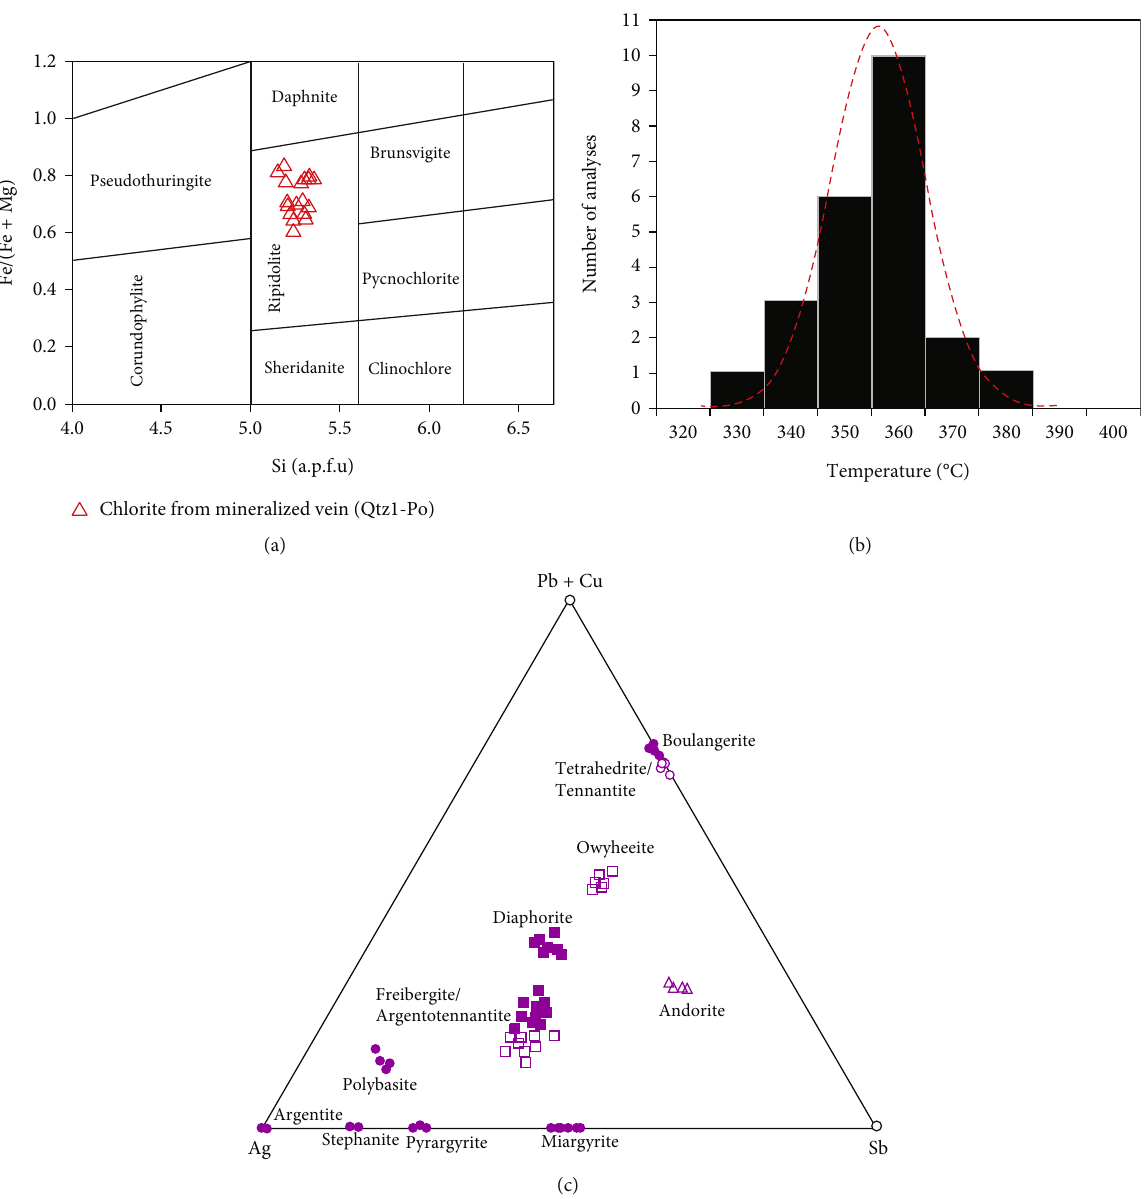
Figure 5: (a) Projection of Roc Blanc chlorites in the classi fi cation diagram of Hey [60]. (b) Histogram of temperatures calculated for the crystallization of Roc Blanc chlorites based on the geothermometer of Kranidiotis and Mac Lean [58]. (c) Triangular Pb+ Cu-Ag-Sb diagram showing the chemical composition of the Ag-rich and sulphosalt minerals from the Roc Blanc